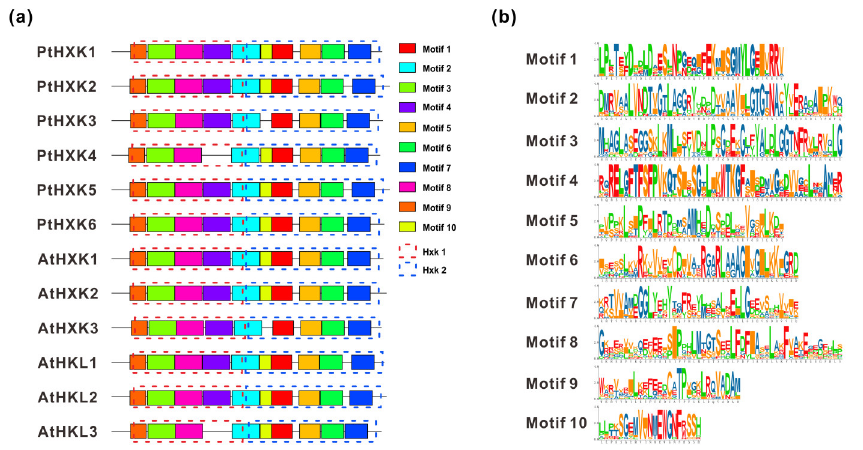
Figure 3. The conserved motif distribution in HXKs. ( a ) Motifs were analyzed using the MEME web server, and ten conserved motifs were boxed in colors. ( b ) The amino acid logos of respective motifs were detailed on the right side.